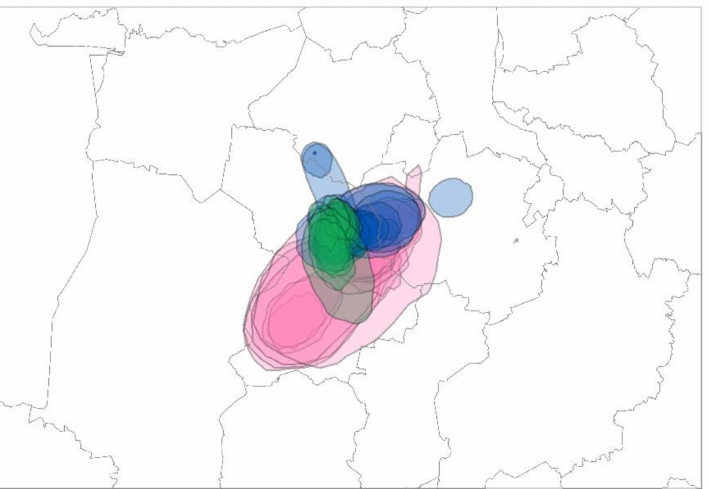
Figure 4. Areas of three poultry clusters identified in Lower Saxony during two seasonal outbreaks, 2016/2017 and 2020/2021. Cluster II CLOL Ger-12-16-N8.2 (2016/2017), blue; Cluster V CL Ger-10-20-N8 (2021), green; Cluster IV CL Ger-10-20-N8 (2020/2021),